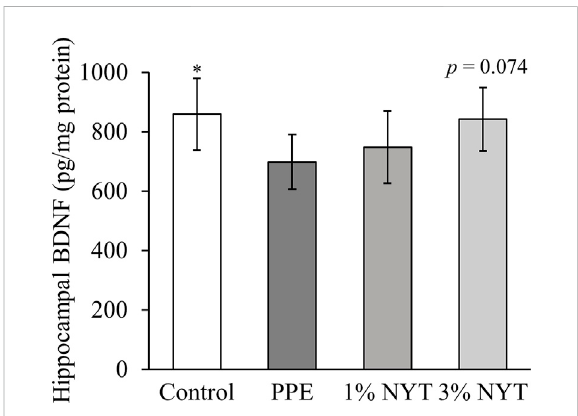
FIGURE 7 Effect of ninjin ’ yoeito (NYT) on hippocampal BDNF protein level in PPE-induced COPD mice. (Control n = 10, PPE n = 11, 1% NYT n = 8, 3% NYT n = 7). Values are expressed as means ± S.D. p p < 0.05 vs. PPE group by Tukey